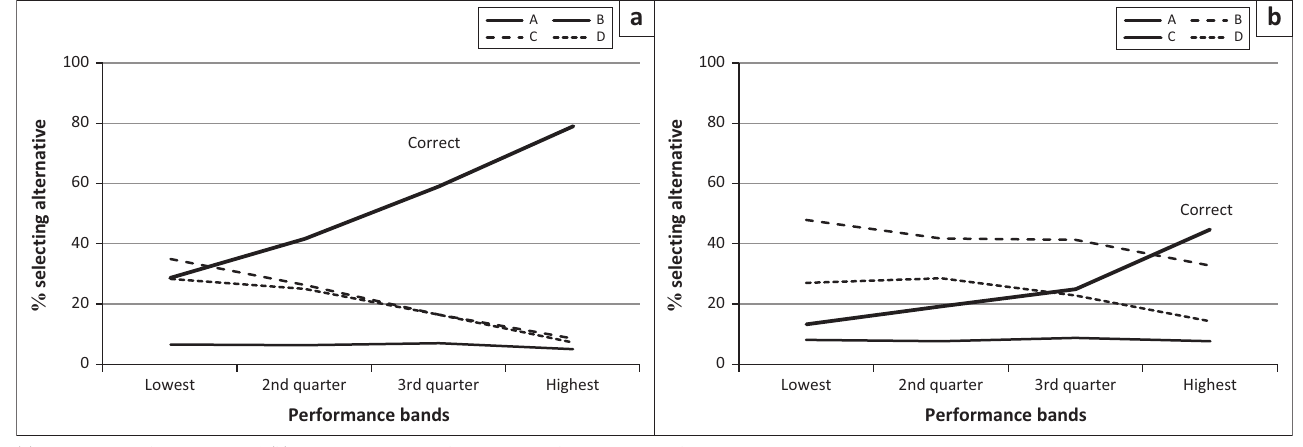
FIGURE 3: Results for comparison problems requiring the comparison of the denominators, by performance